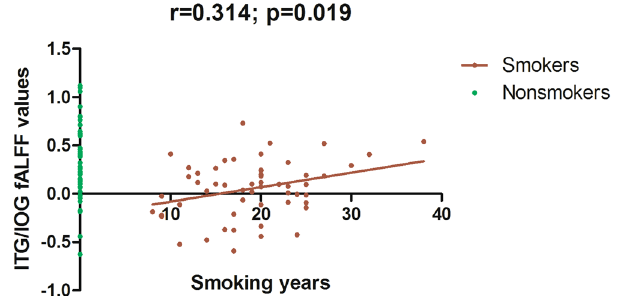
Figure 3. The fALFF values of the right ITG/IOG were positively correlated with smoking years across the smokers (r = 0.314; p = 0.019).